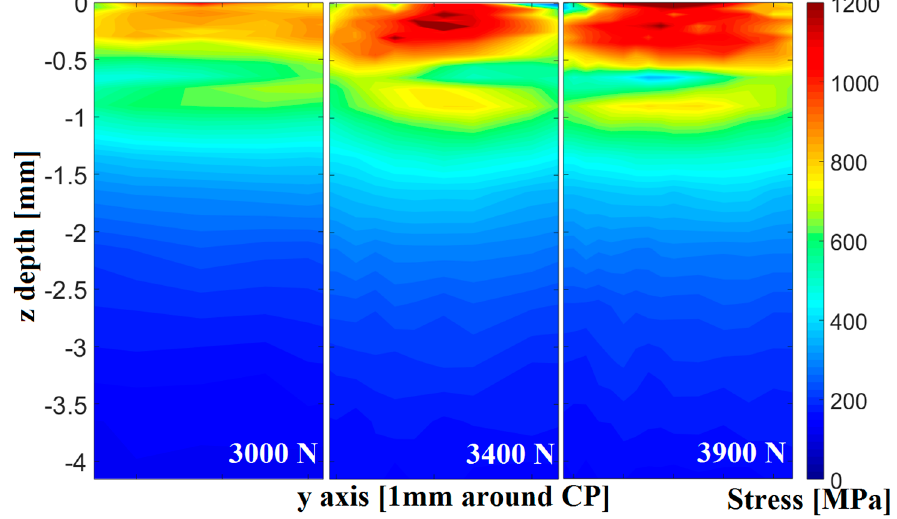
Figure 4. Equivalent loading stress σ eq distribution at contact point (y = 0 mm) for three different contact forces.